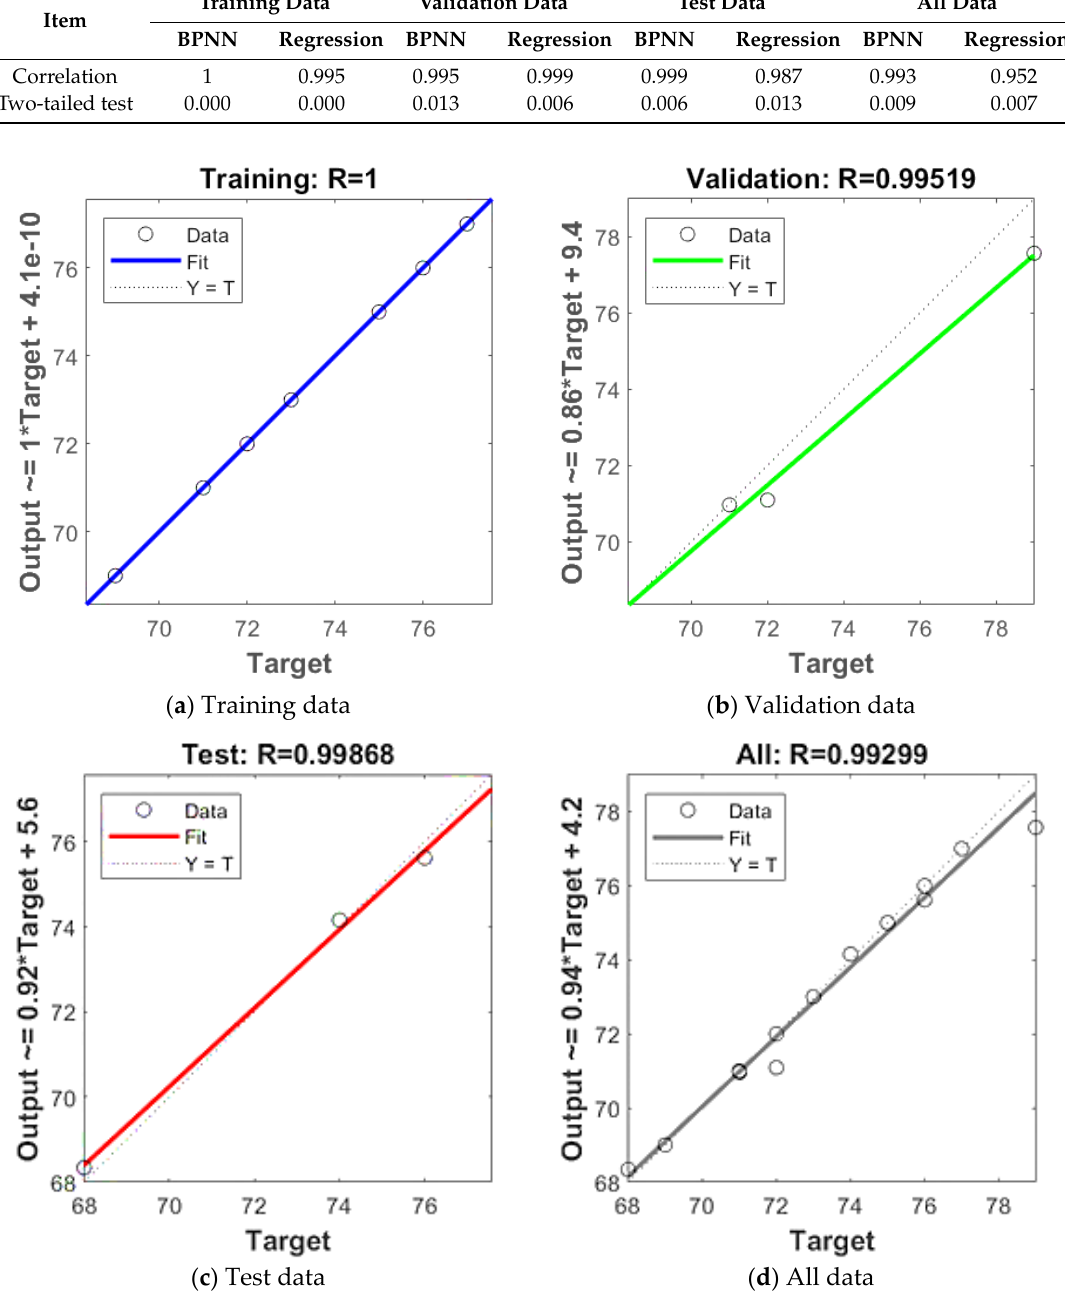
Figure 3. Relationships between prediction values from the BPNN model and current noise limits.